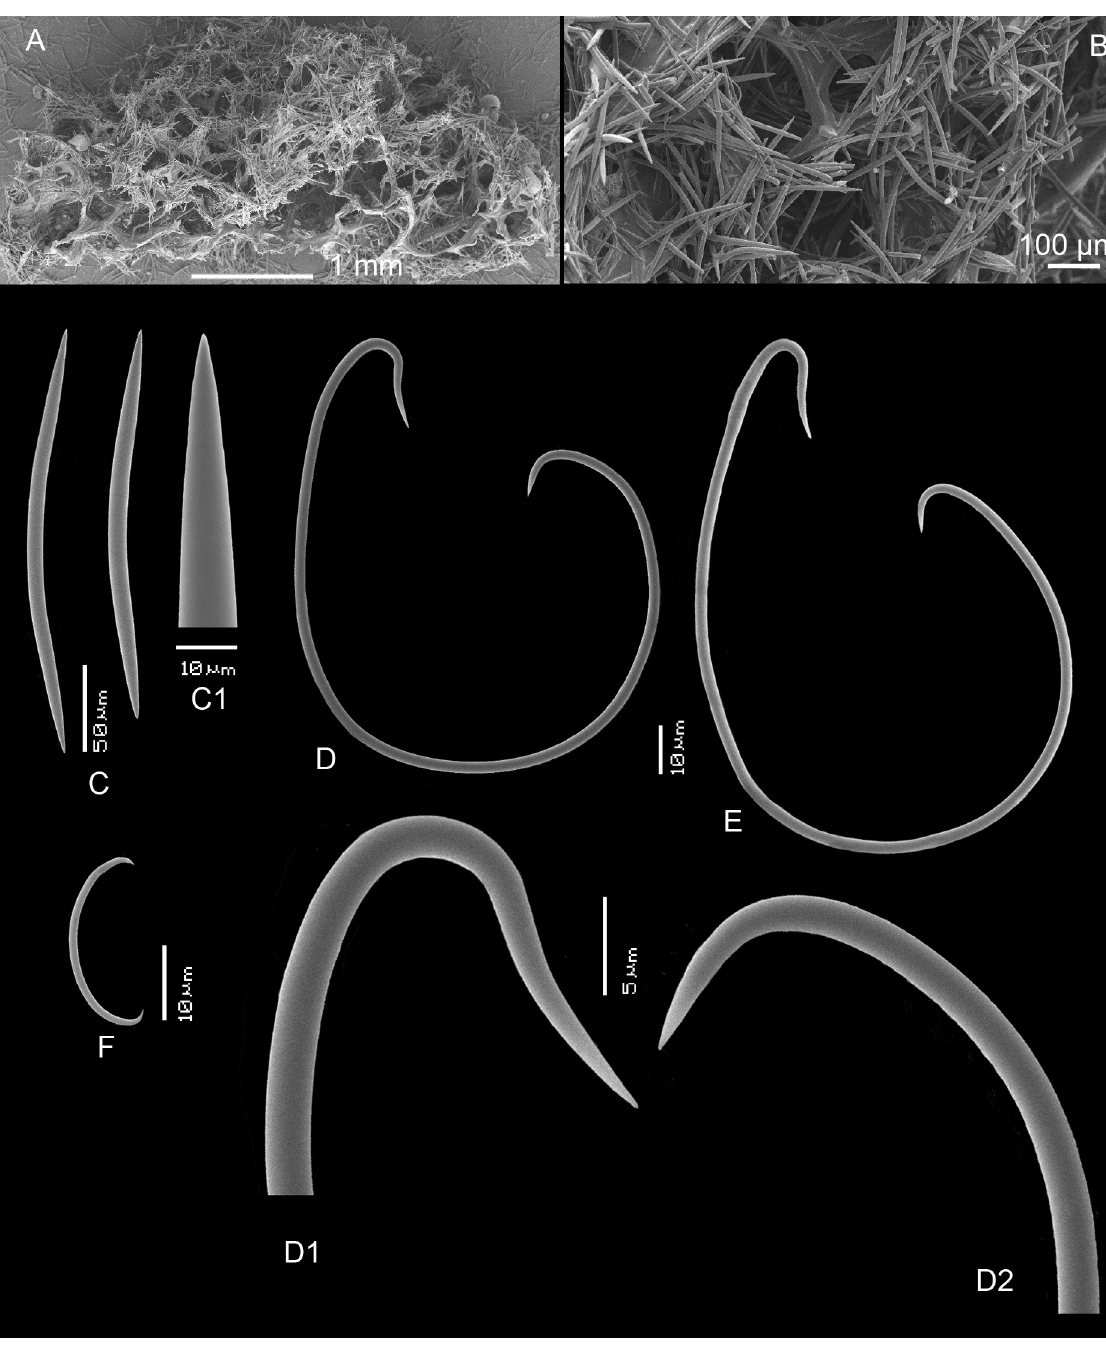
. Detail 1 . Detail of short 2